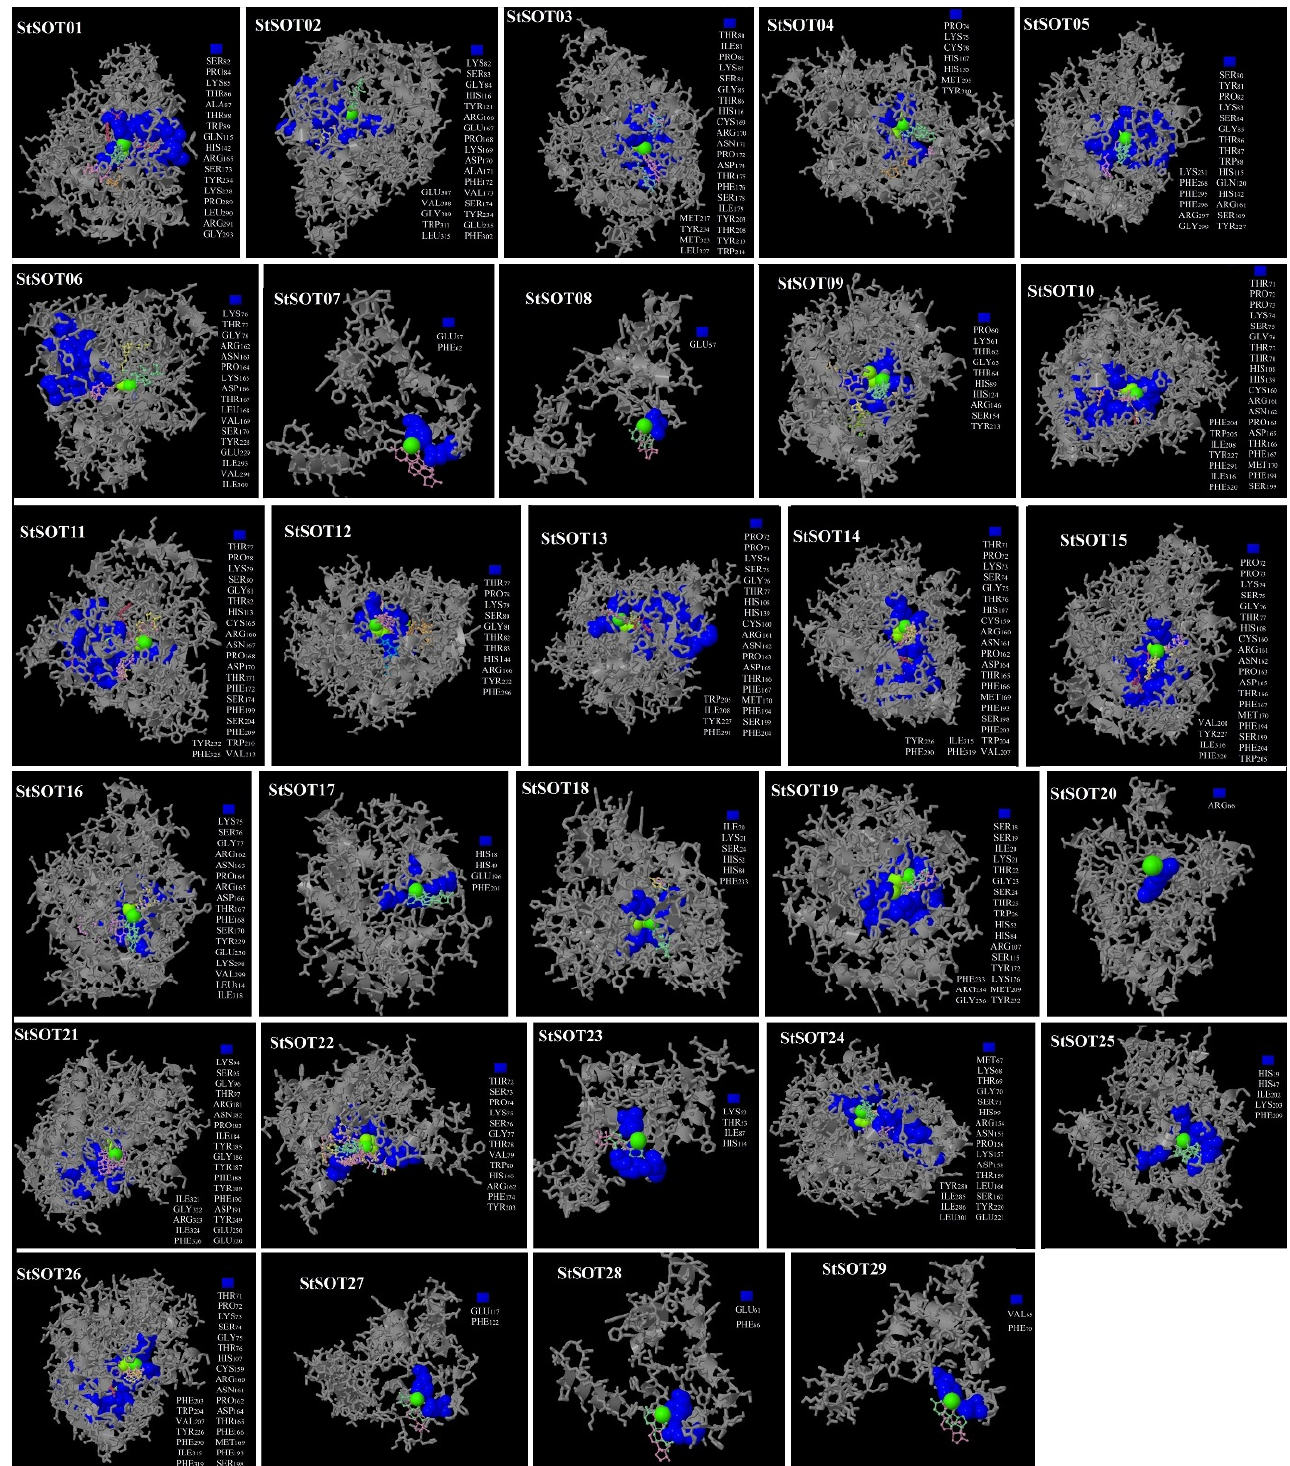
Figure 8. Three-dimensional docking analysis of StSOT protein ligand-binding sites. The binding residues, metallic heterogeneous and non-metallic heterogeneous are shown in blue spacefill, green spacefill, and colorful wireframe, respectively.